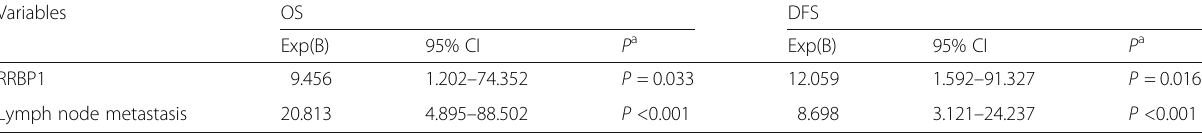
FIGO, International Federation of Gynecology and Obstetrics; G1, well differentiated; G2, moderately differentiated; G3, poorly differentiated; RRBP1, Ribosome- binding protein 1; OS, overall survival; DFS, disease-free survival; a Cox regression